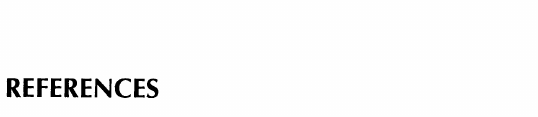
FIGURE 4 Singular values of the input cross-spectral density matrix for the